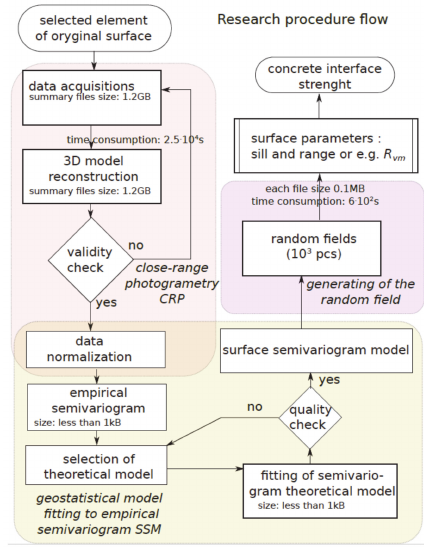
Figure 6. Block diagram of the shear strength parameter